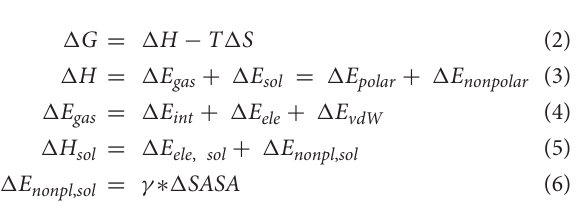
Frontiers in Chemistry |